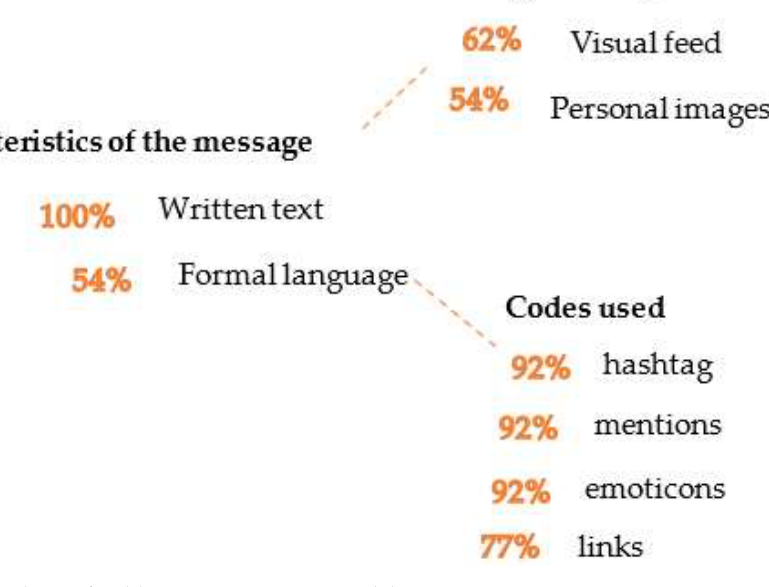
Figure 5. Analysis of publications. Source: own elaboration.